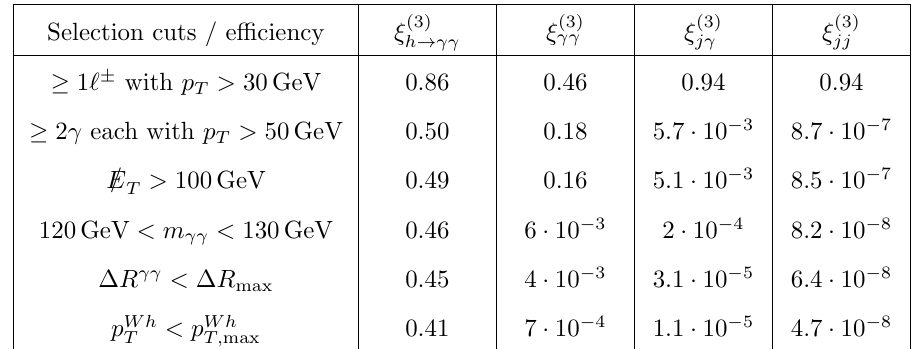
Table 4 . Cut-(cid:13)ow e(cid:14)ciency for the selection cuts. The superscript, (3), refers to the third p h at generation